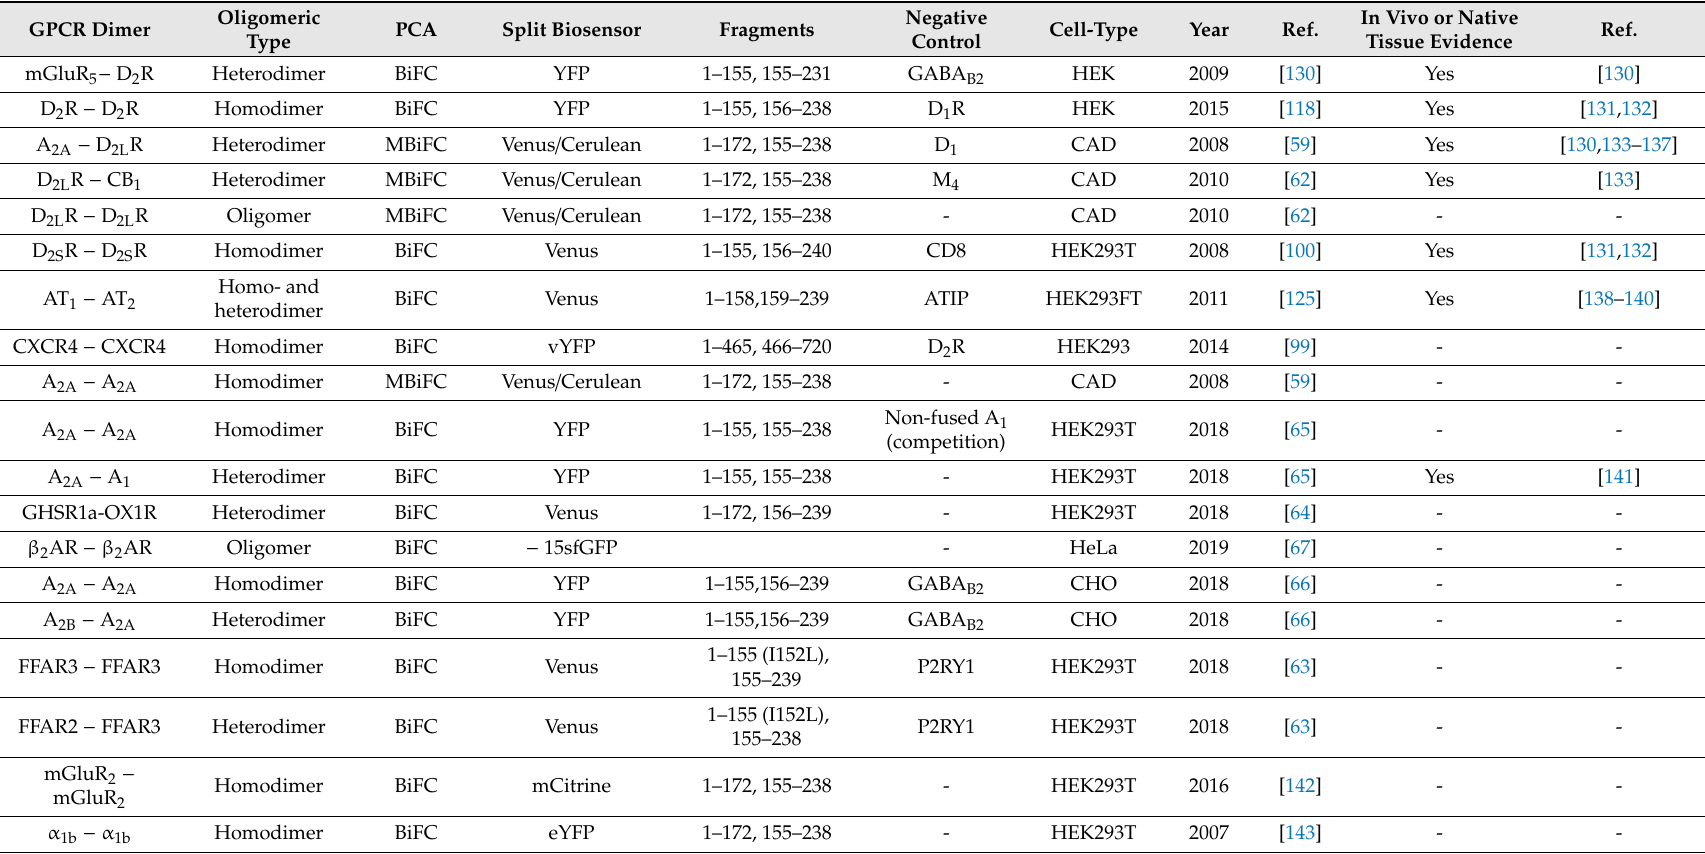
Table 5. An overview of GPCR–GPCR interactions, shown by fluorescence complementation